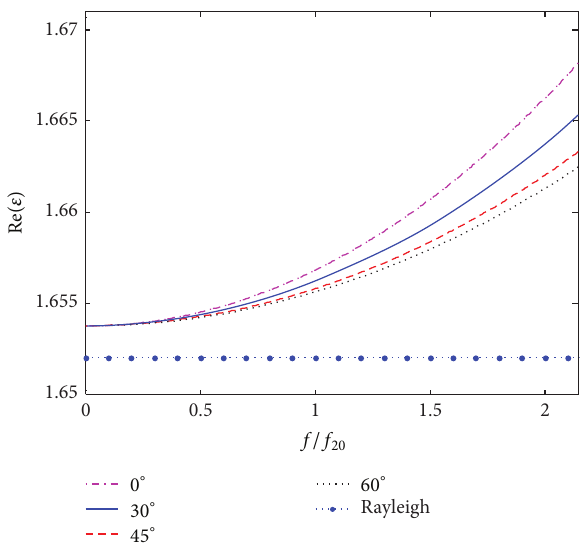
Figure 5: The retrieved permittivities as a function of 𝑓/𝑓 20 at